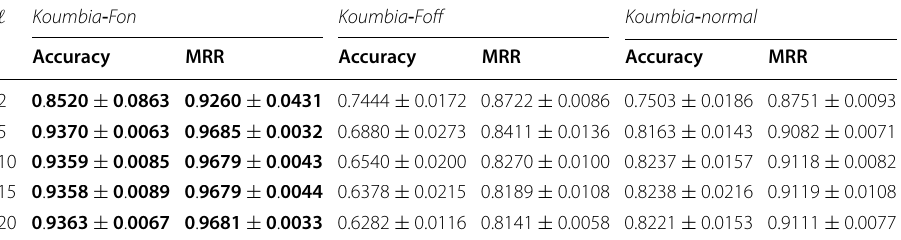
Table 12 Performance of ML-GCN over the Koumbia multilayer networks with varying number of layers, and different types of input features